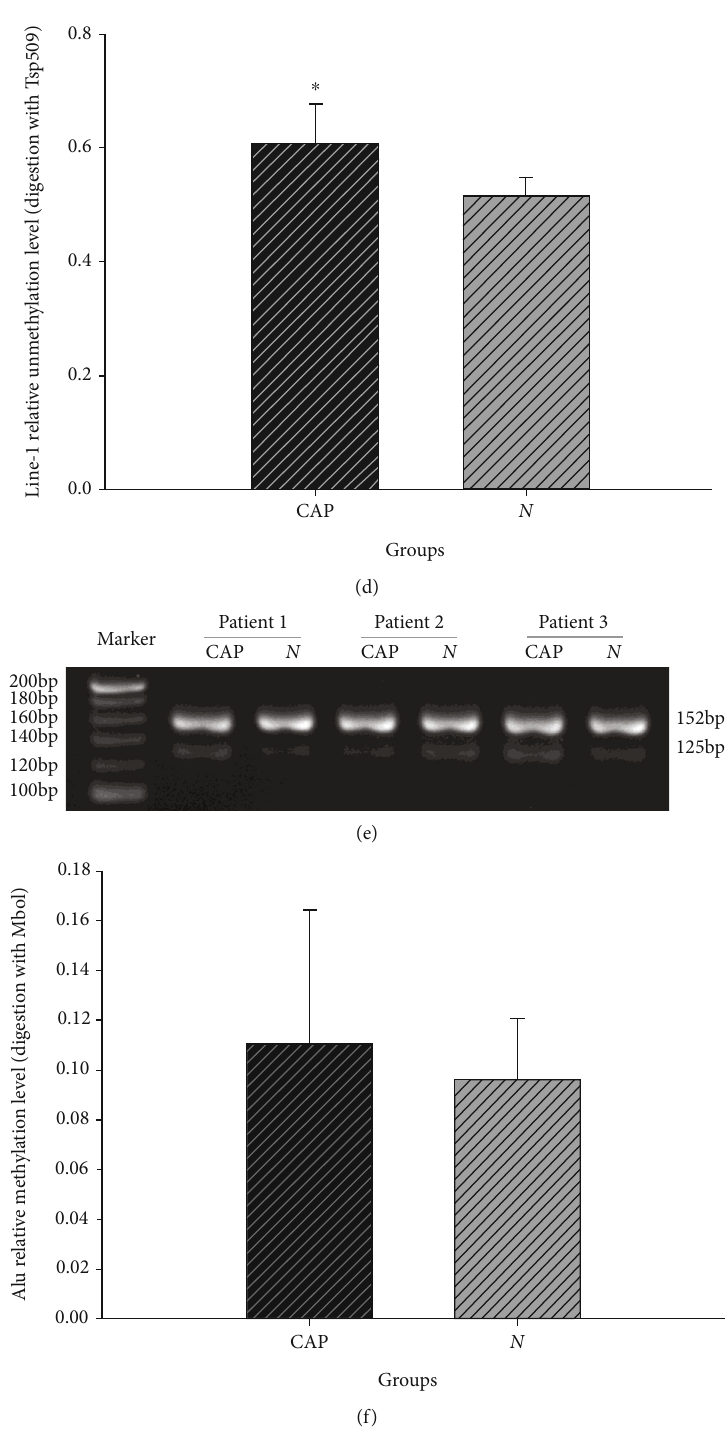
Figure 3: Global methylation of LINE-1 and Alu in CAP and NCM tissues. (a) Representative electrophoresis images of COBRA products (LINE-1 DNA sequence + Taq1 digestion). (b) The statistical analysis showed the rate of DNA methylation in the LINE-1 DNA sequence has a di ff erence between CAP and control tissues( ∗ P < 0 : 05 ). (c) Representative electrophoresis images of COBRA products (LINE-1 DNA sequence + TSP509I digestion) in agarose gel. (d) The statistical analysis showed the rate of DNA unmethylation in the LINE-1 DNA sequence has a di ff erence between CAP and control tissues( ∗ P < 0 : 05 ). (e) Representative electrophoresis images of COBRA products (Alu DNA sequence + Mbo1 digestion). (f) The statistical analysis showed the rate of DNA methylation in Alu DNA sequence did not exhibit any di ff erence between CAP and control